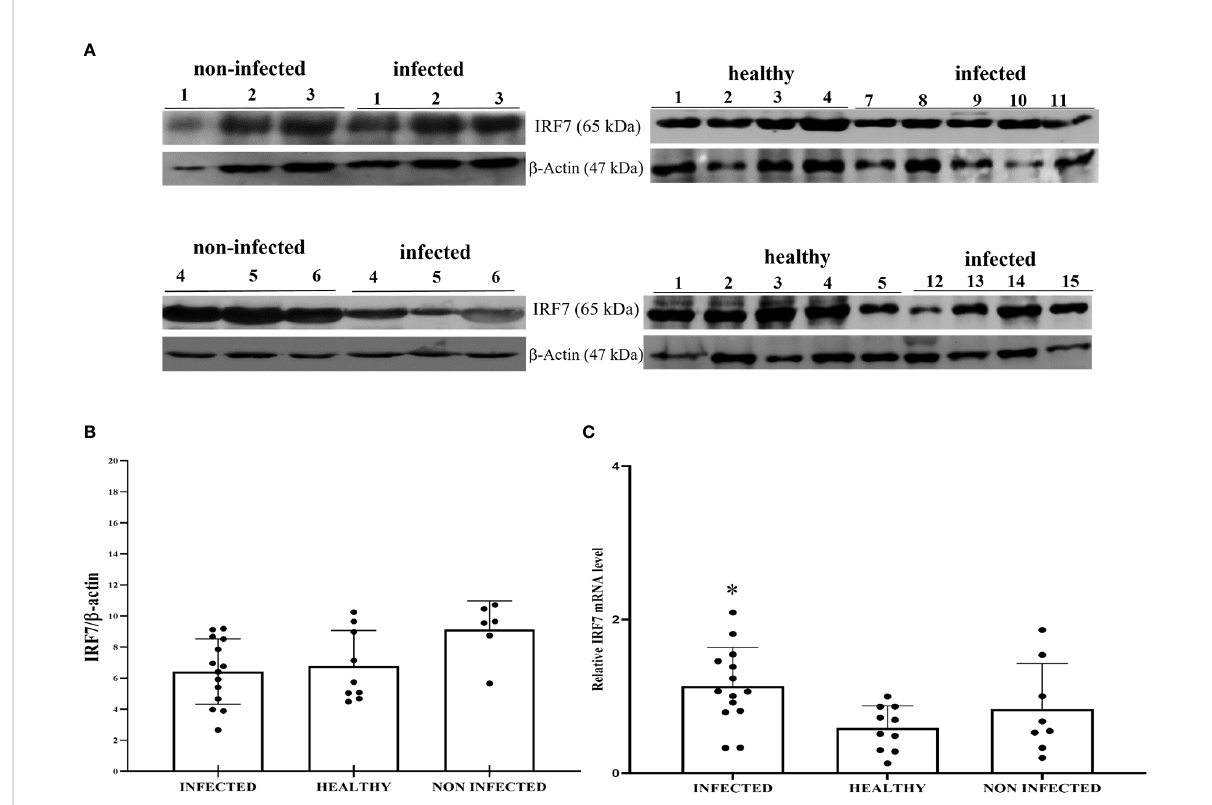
FIGURE 9 (A) Western blot analysis of total IRF7 protein in infected, non-infected, and healthy bladder samples. (B) Densitometric analysis of IRF7 protein abundance relative to b -actin protein levels. Plots present values found for each sample performed in triplicate. (C) RT-qPCR analysis of IRF7 mRNA levels in infected, non-infected, and healthy bladder samples, respectively. A signi fi cant variation in IRF7 mRNA expression levels was observed in diseased bladder tissue compared with both non-infected and healthy bladder samples (*p ≤